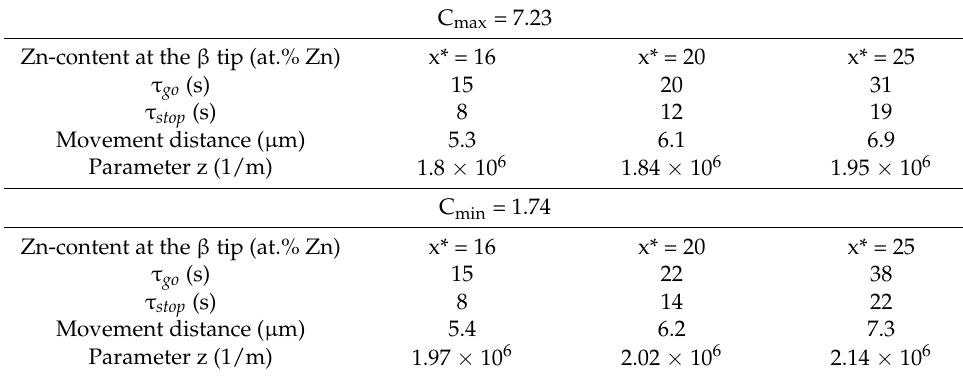
Table 2. Results of the simulation for λ α = 150 nm, v DD = 0.5 nm/s and various values of x* . C max = 7.23